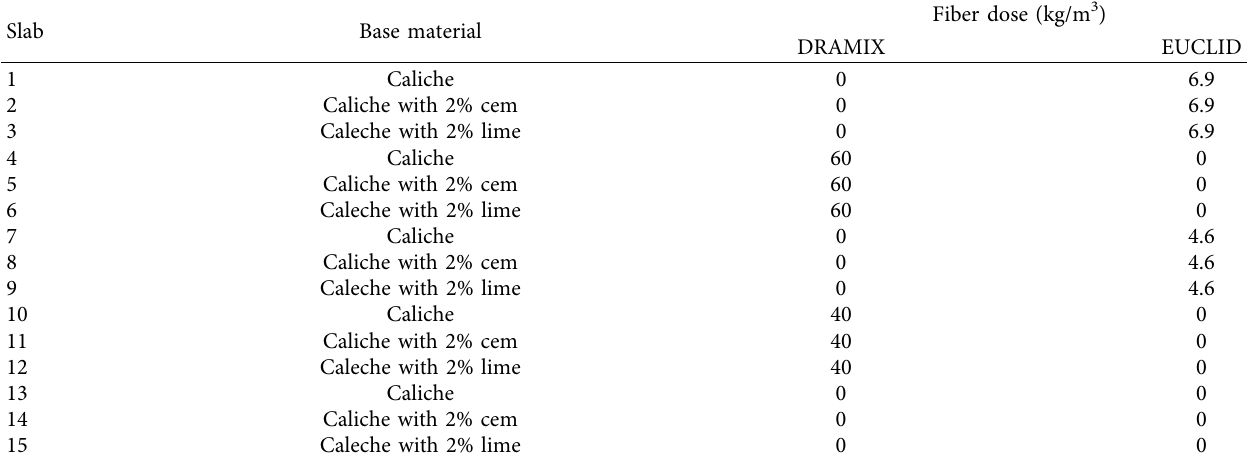
Table 9: Slab specifcation.